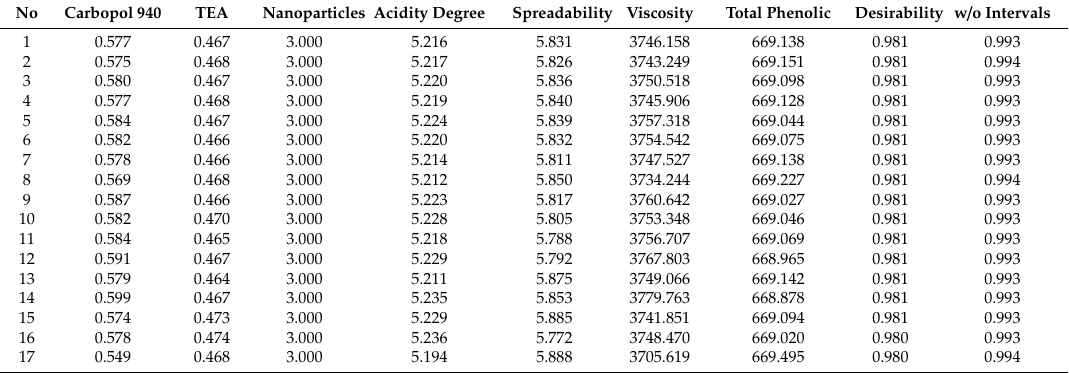
Table 8. The solution of optimum formulation arabica co ff ee ground nanoparticles gel preparations. No Carbopol940 TEA Nanoparticles Acidity Degree Spreadability Viscosity Total Phenolic Desirability w / o